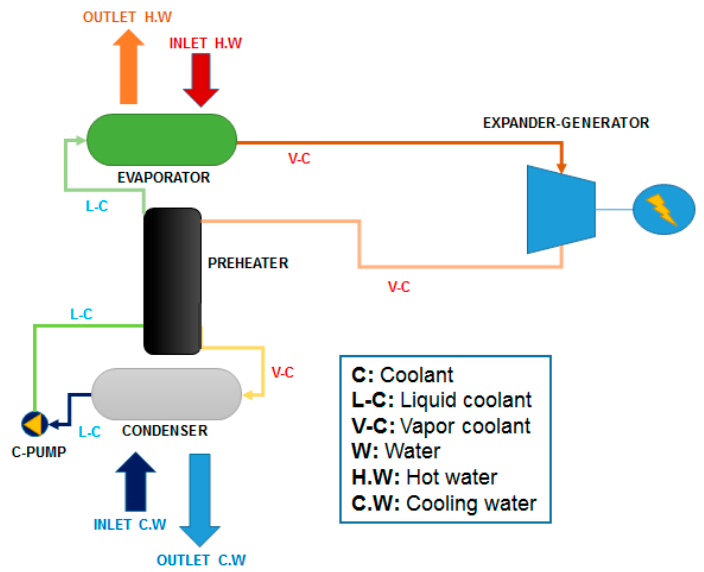
Figure 2. Drawing of the ORC module employed.